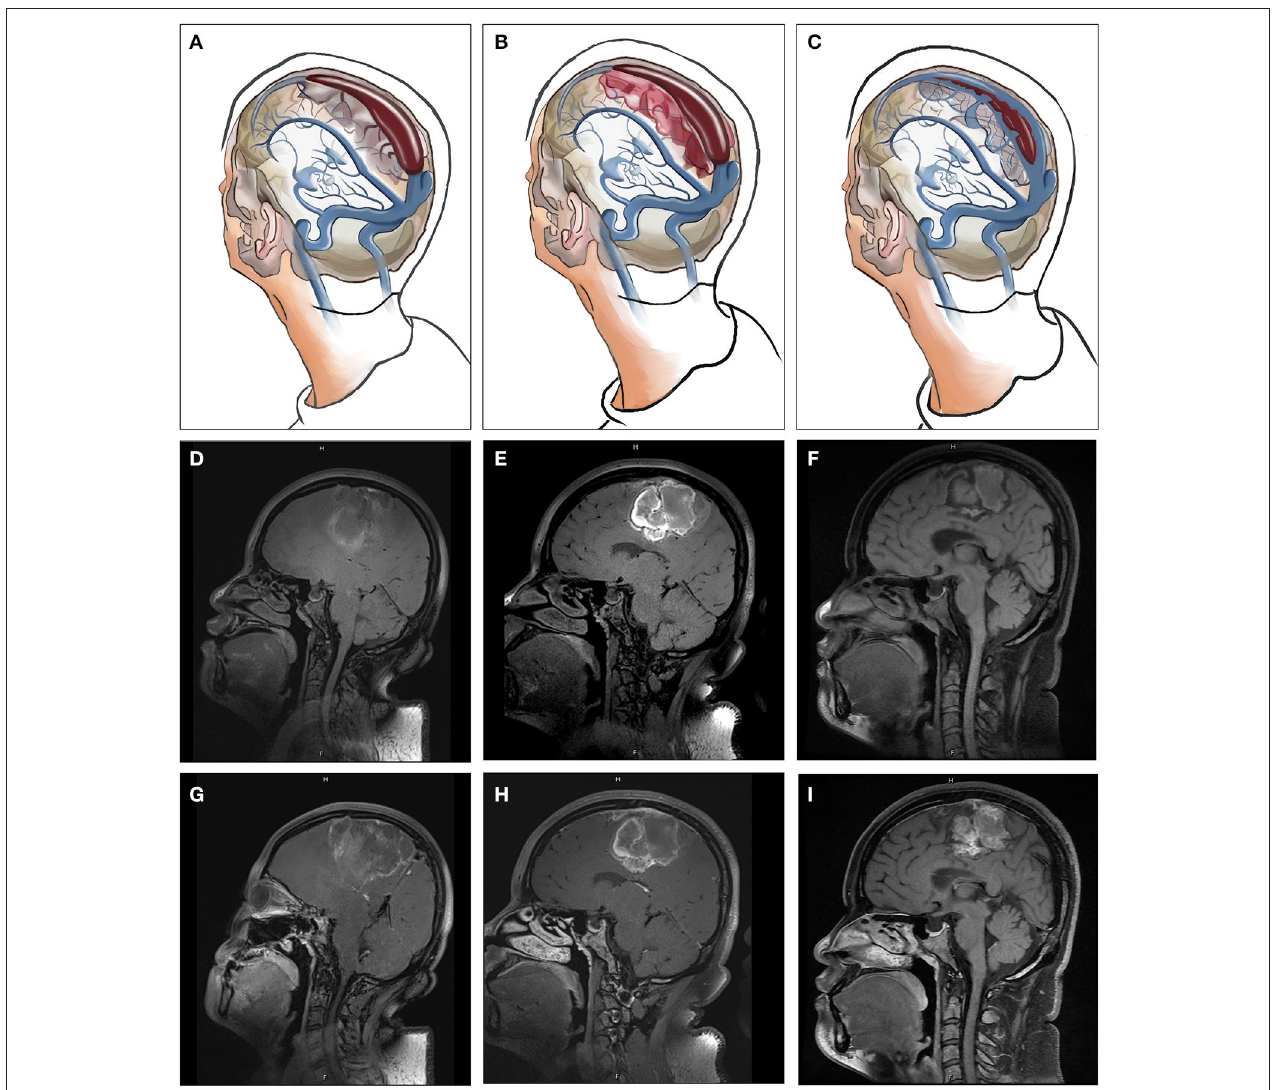
FIGURE 3 | The relationships between CCVT and CVSS (A–C) , Non-enhanced (D–F) , and contrast-enhanced (G–I) HR-MRBTI of the brain in Case 3 (on admission). Initially, venous drainage insufficiency may induce enlargement of arachnoid granulations within the sinuses, resulting in hemodynamic changes in the sinuses and resultant endothelial damage and dysfunction, which can then lead to CVSS. Thrombosis may develop in cortical veins near CVSS. Finally, under standard therapy with anticoagulation, CCVT and CVSS may experience partial or full